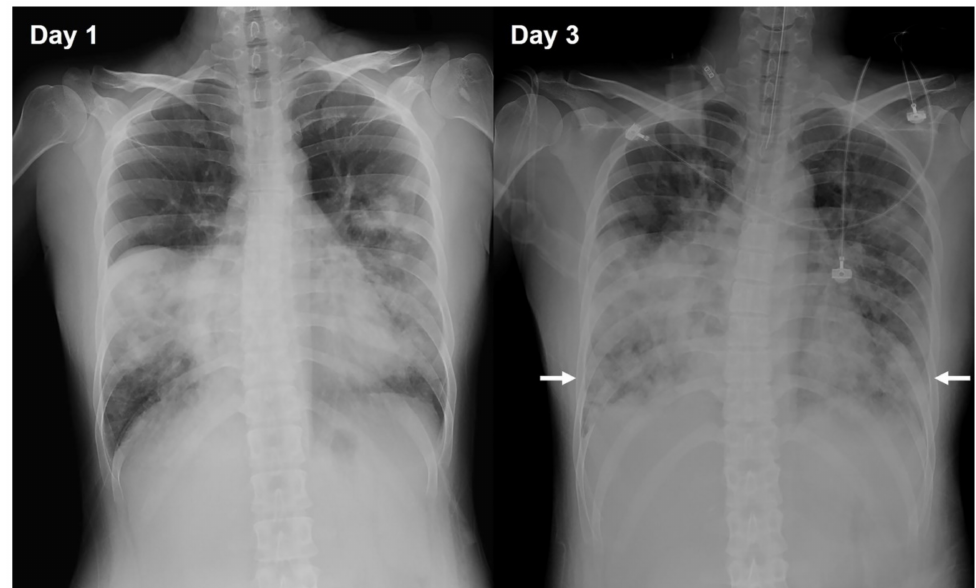
Figure 1. Chest radiographs showing the progression of pneumonia. Chest radiograph on day 1 ( left ) and day 3 ( right ). The radiograph performed on day 3 shows the progression of the pneumonia, with patchy opacification in the lower lobes of the lungs